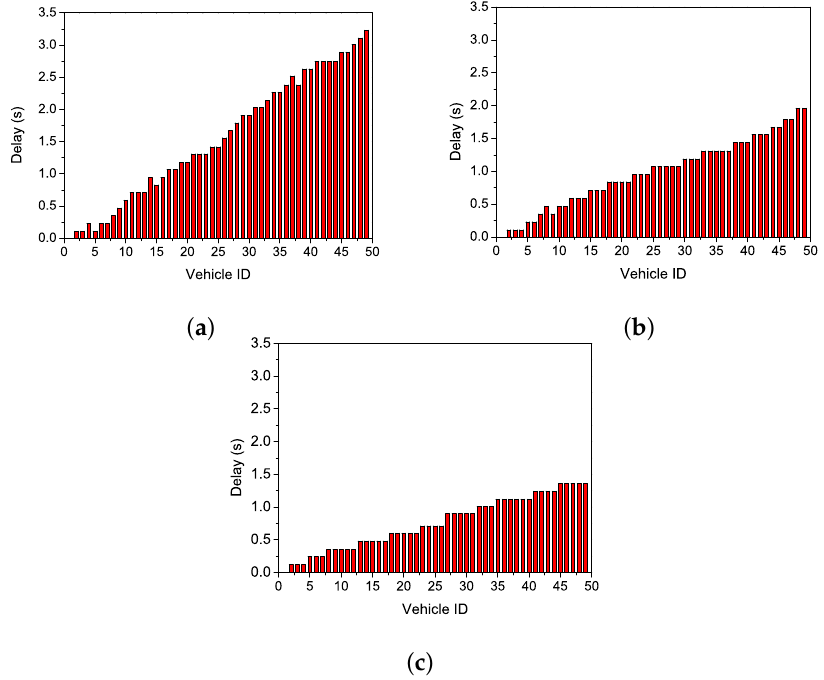
Figure 5. Comparisons of delay. ( a ) VeMAC. ( b ) CAH-MAC. ( c )